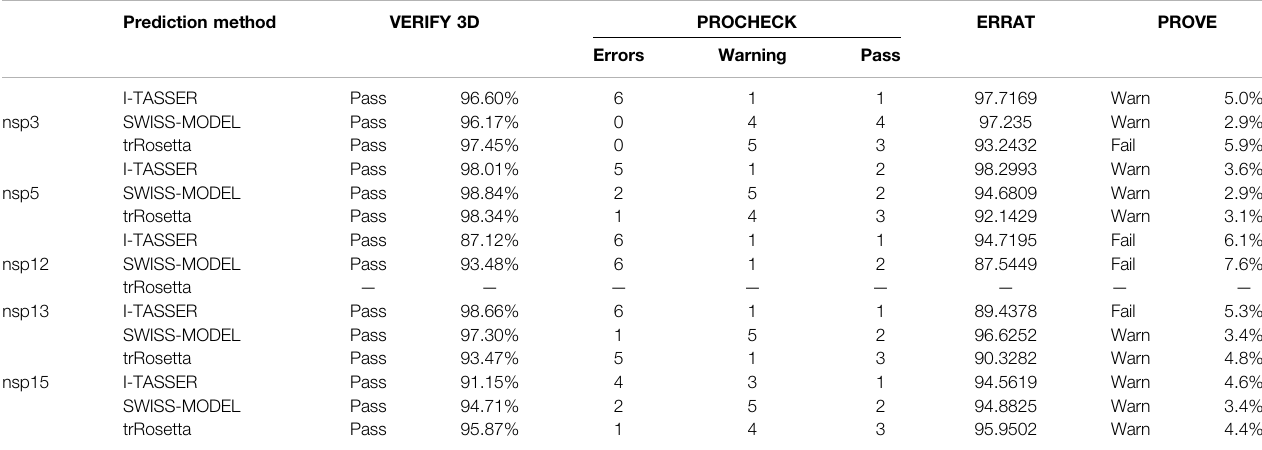
TABLE 1B | Quality assessment of the predicted 3D model of targets.